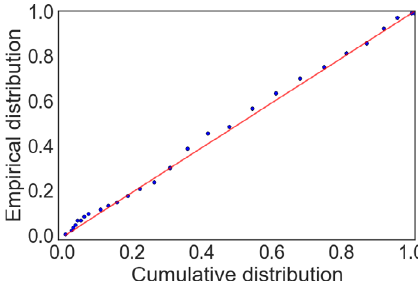
Fig. 7. Quantile – quantile plot of the empirical distribution of p - values (dotted) vs. a uniform distribution (solid line) for Random bits from Hotbits [11].